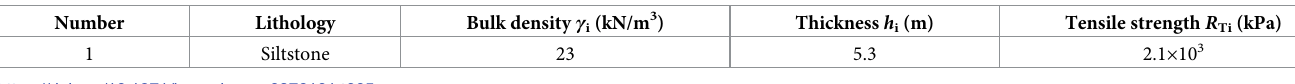
Table 5. Physical and mechanical parameters of roof strata above No.8 coal seam.